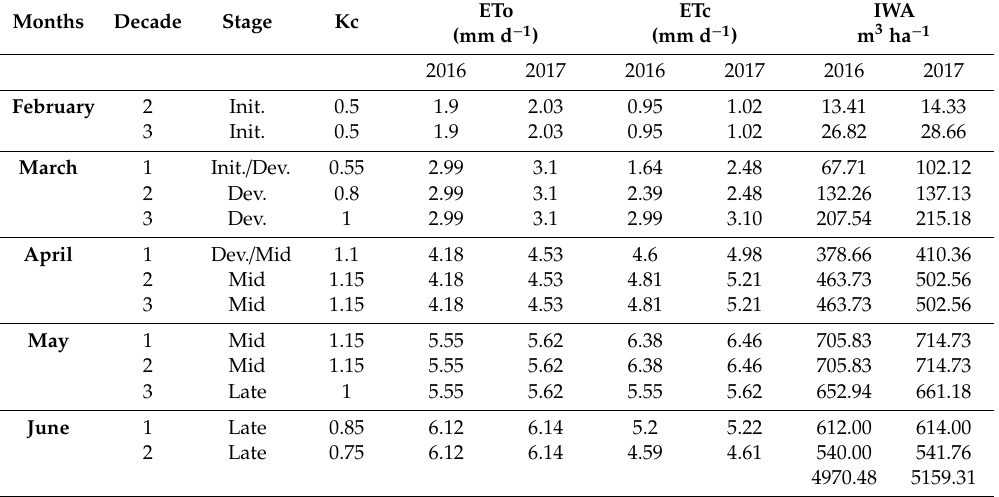
Table 5. Potato crop evapotranspiration and irrigation water applied for two successive years (2016 and